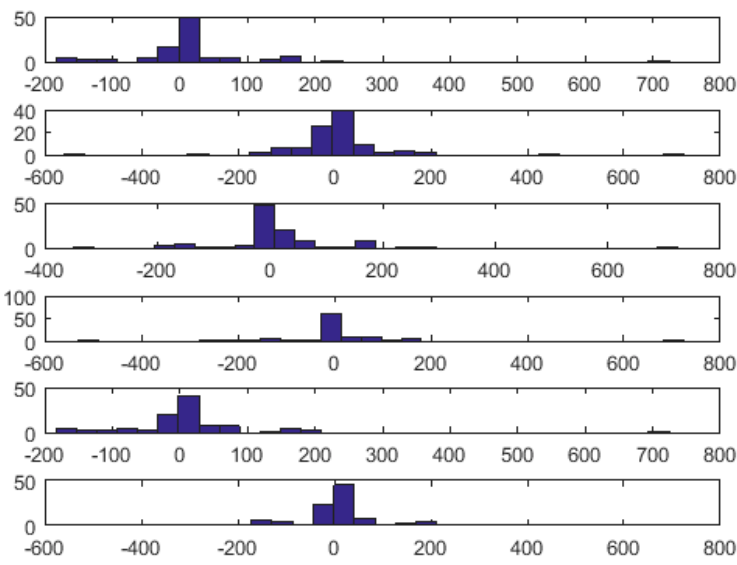
Figure 6. Histograms of QRS length error distribution for 1 bit depth watermark coding (worst case) with different wavelets (top to bottom): db5, db10, sym6, sym11, bior2.4 and bior 4.4.